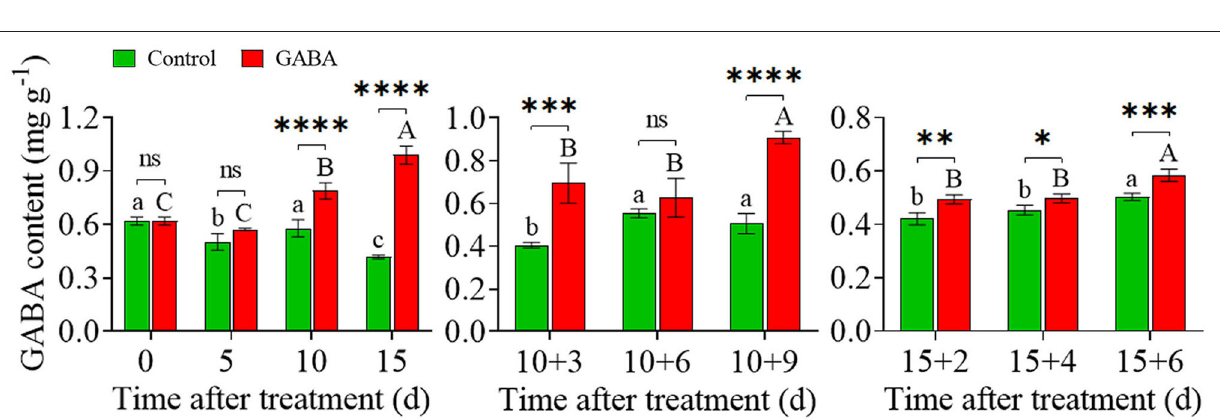
FIGURE 6 | The phospholipase D (PLD) (A) and lipoxygenase (LOX) (B) activities of carambola fruit during storage at 4 and 25 ◦ C. Error bars are expressed as means ± SD (standard deviation) of three replicates (n = 3). The asterisks indicate statistically significant differences between treatments at * p < 0.05, ** p < 0.01, *** p < 0.001, **** p < 0.0001, ns, not significant.